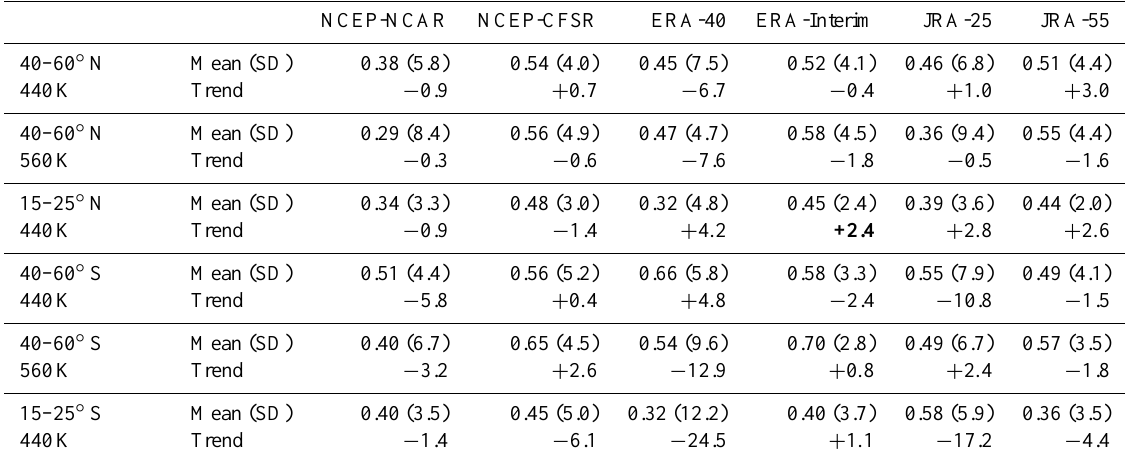
Figure 9. Same as Fig. 2 but for the ratio of the relative importance of the eddy transport to the total meridional transport. Table 7. Same as in Table 1, but for the relative importance of the eddy transport to the total meridional transport averaged over 40–60 ◦ N at 440 and 560K and 15–25 ◦ N at 440K in DJF, and over 40–60 ◦ S at 440 and 560K and 15S–25 ◦ S at 440K in JJA, and its linear trend slope (in %decade − 1 ). The linear trend with a confidence level greater than 95% is shown in